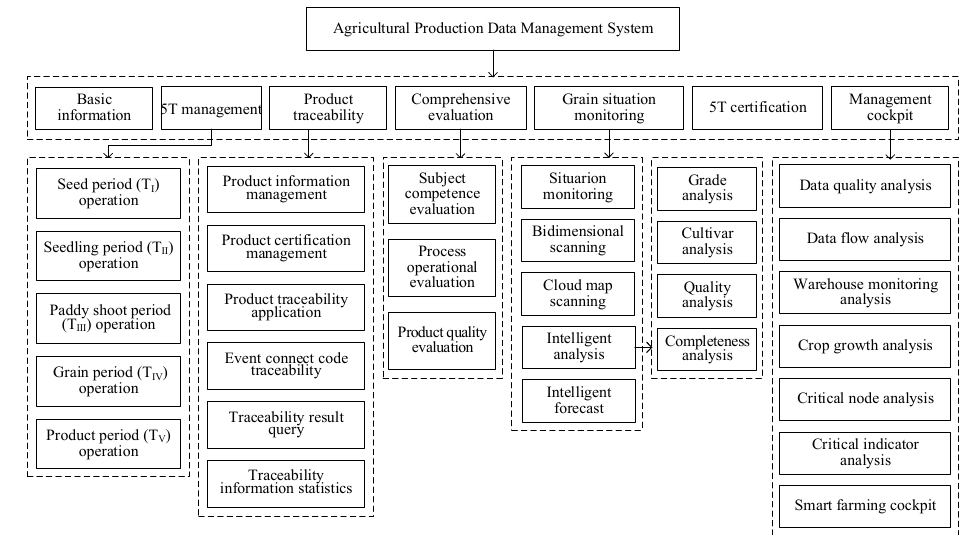
Figure 11. The system architecture of Agricultural Production Data Management Sys- tem [76].